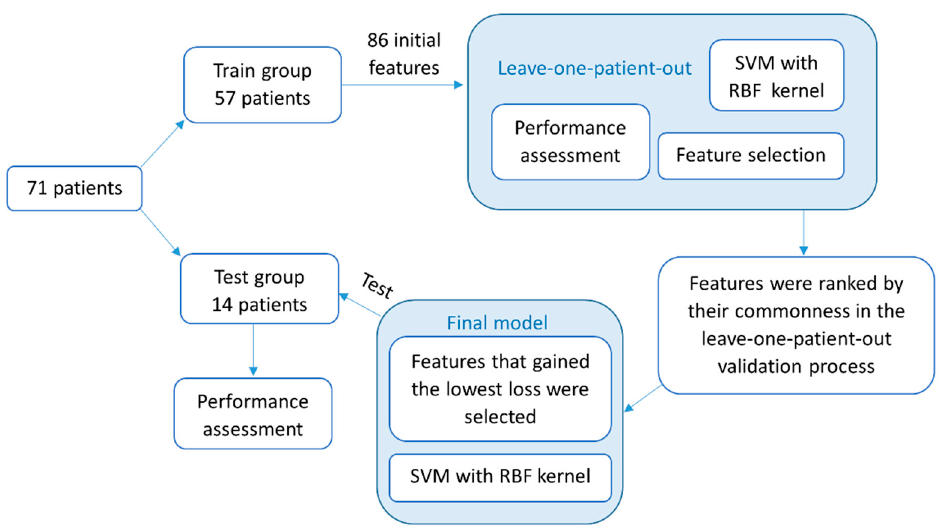
Figure 3. A flowchart of the methodology described in this paper for the detection of FOG episodes with a machine-learning classifier. First described are the feature-selection and -validation processes in a leave-one-patient-out method. Then, the construction and testing of the final model. SVM, support vector machine; RBF, radial basis function.